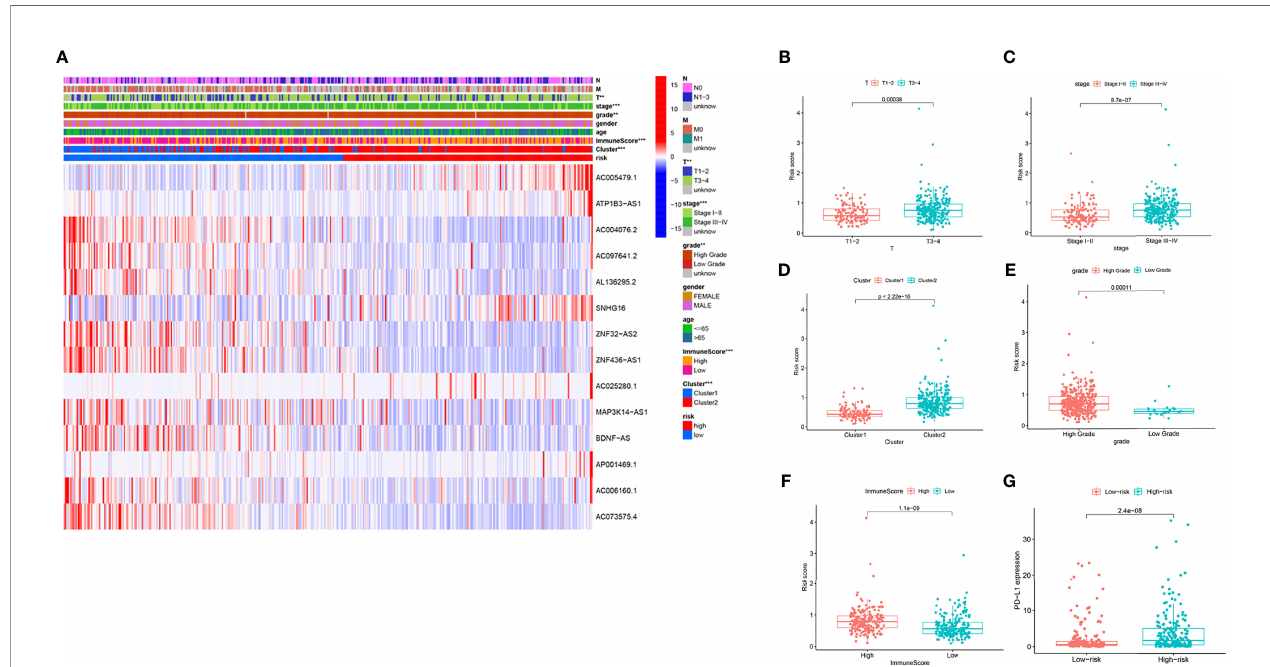
FIGURE 7 | The prognostic risk score was correlated with clinicopathological features and immune score in the TCGA datasets. (A) Heatmap and clinicopathologic features for the high- and low-risk groups. (B – F) Distribution of risk scores strati fi ed by T stage (B) , stage (C) , cluster (D) , grade (E) and, immune score (F) . (G) PD- L1 expression by risk score group in the TCGA datasets. ** P < 0.01; *** P < 0.001.